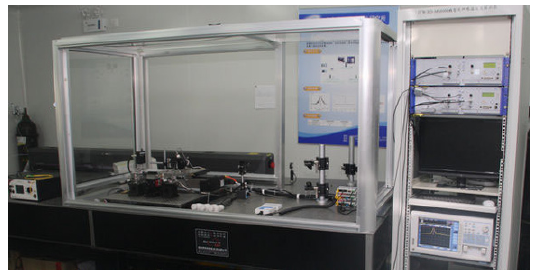
Fig. 1 Grating fabrication system of argon ion